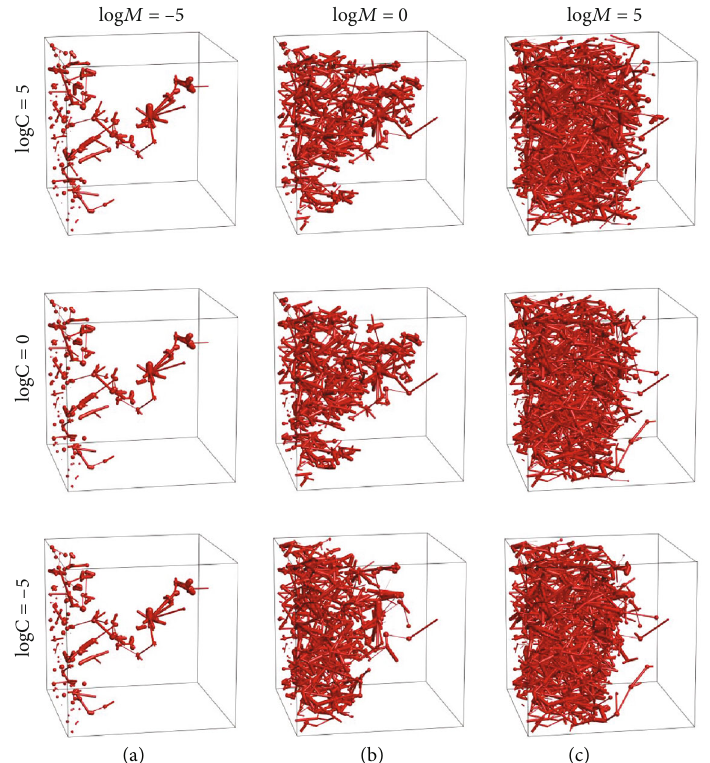
Figure 3: Typical invasion patterns for selected log M and log C conditions. The fl uid invaded from the left boundary to the right